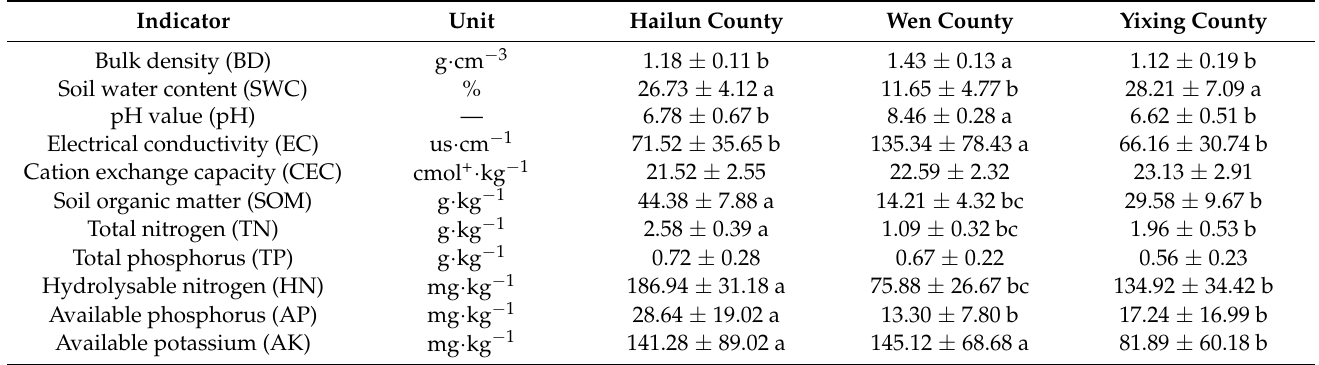
Table 1. Multiple comparisons of the soil physico-chemical properties of agricultural land in the different regions